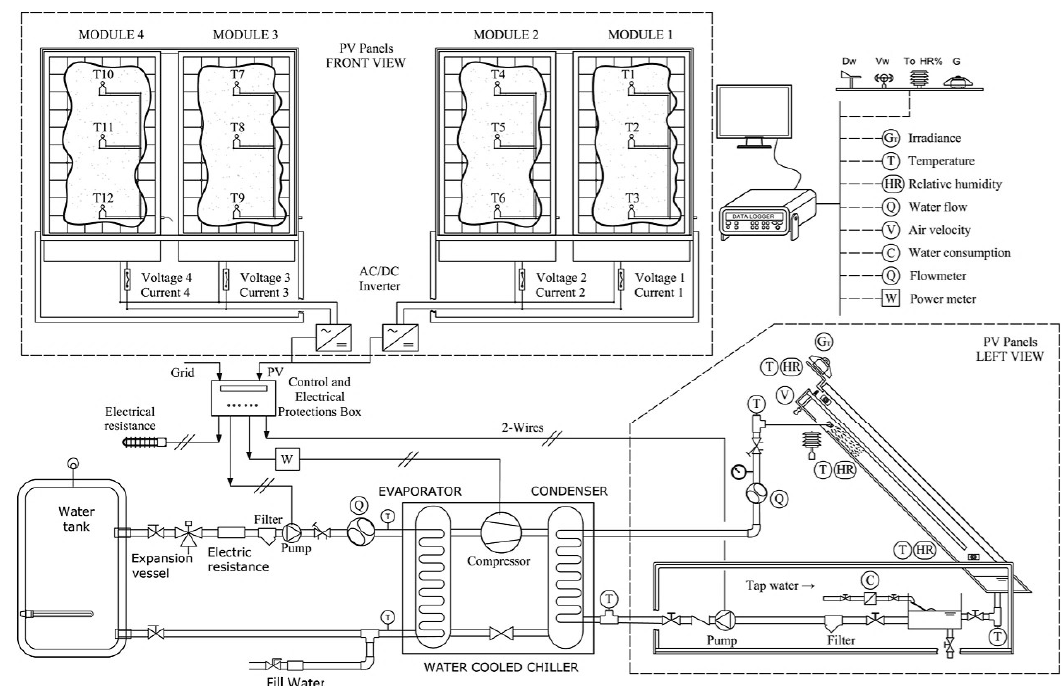
Figure 6. Schematic diagram of the experimental measuring equipment. Reprinted from Ruiz et al. [20] with permission from Elsevier,